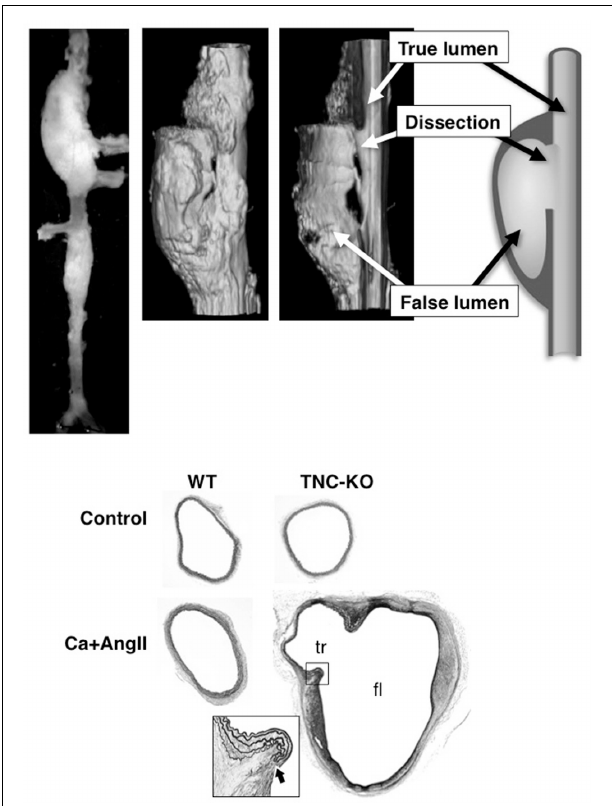
FIGURE 4 | AAD in TNC-KO mice. Morphology of mouse AAD in TNC-KO mice. Top panels: A macroscopic image, 3D-reconstitution of optical sections obtained by optical coherence tomography with a cut-out view, and a schematic of the cut-out view. Bottom panels: Elastica van Gieson staining of the suprarenal aorta. True (tr) and false (fl) lumens are indicated in TNC-KO with Ca + AngII treatment. The inset is the magnified view of the dissection site (thick arrow) as indicated by the rectangle. Adapted from Kimura et al.